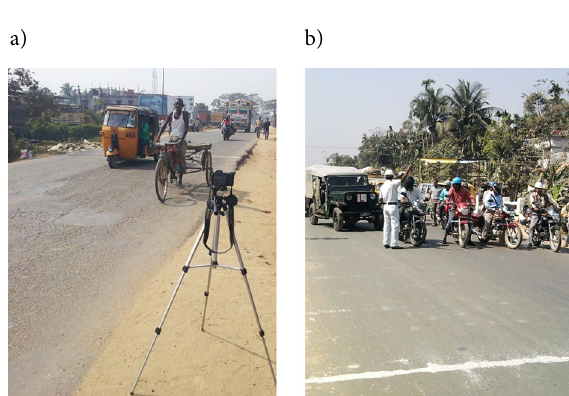
Fig. 2. Observed hourly traffic flow variation on the selected highway section